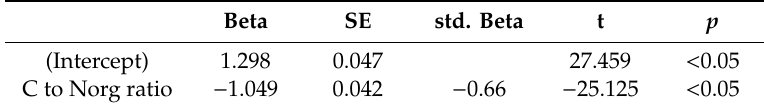
Table 3. Forward stepwise linear regression analysis of N 0 for the parameters C to N org ratio, N content of the fertilizer, incubation temperature, and soil class.